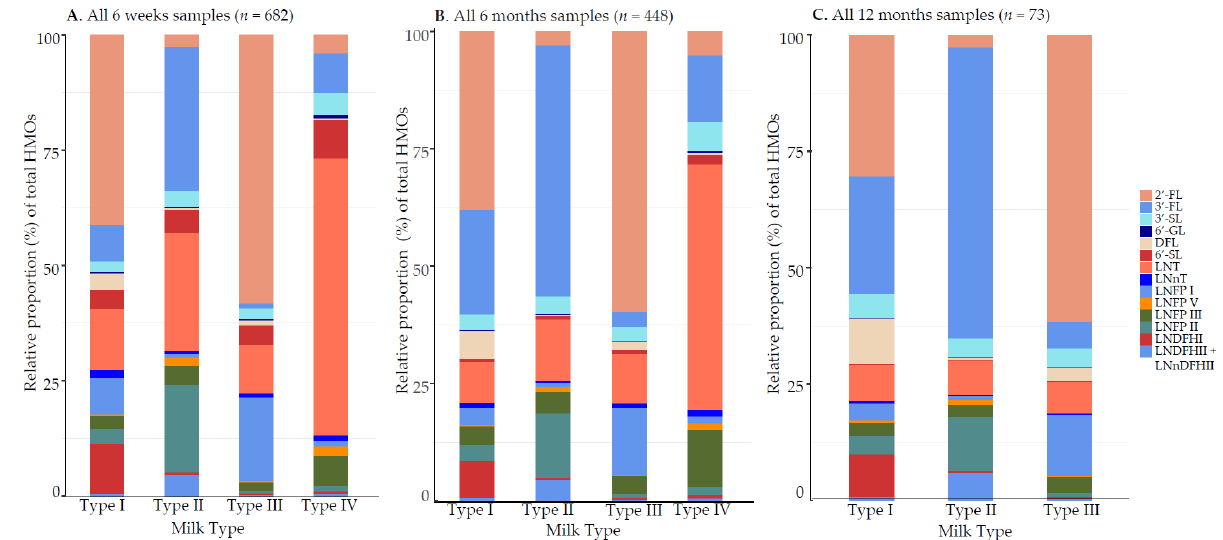
Figure 1. Relative proportion (%) of total human milk oligosaccharide (HMO) concentrations according to human milk group, in samples collected at 6 weeks, 6 months, and 12 months of lactation. Percentages of total HMOs were calculated for all women at ( A ) 6 weeks; ( B ) 6 months; and ( C ) 12 months according to the four different milk groups. 2 ′ -FL, 2 ′ - fucosyllactose; 3-FL, 3-fucosyllactose; 3 ′ -SL, 3 ′ -sialyllactose; 6 ′ -GL, 6 ′ -galactosyllactose; DFL, 3,2 ′ -difucosyllactose; 6 ′ -SL, 6 ′ - sialyllactose; LNT, lacto-N-tetraose; LNnT, lacto-N-neotetraose; LNFP I, lacto-N-fucopentaose I; LNFP V, lacto-N-fuco-